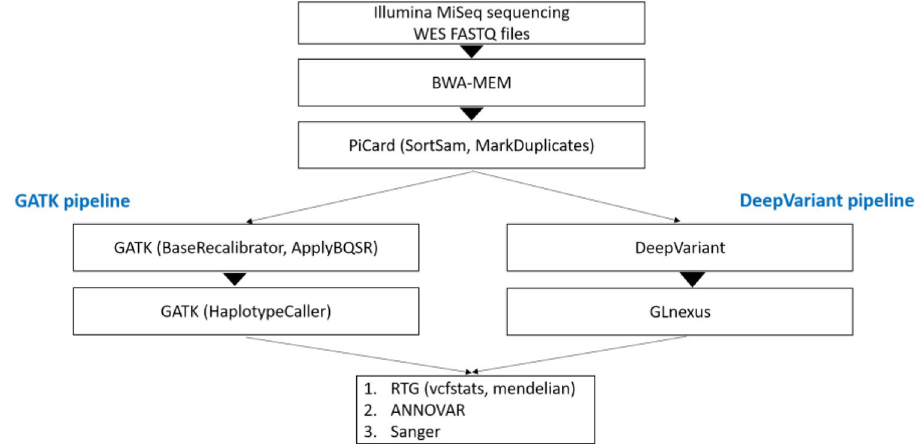
Figure 4. Algorithm of the bioinformatics